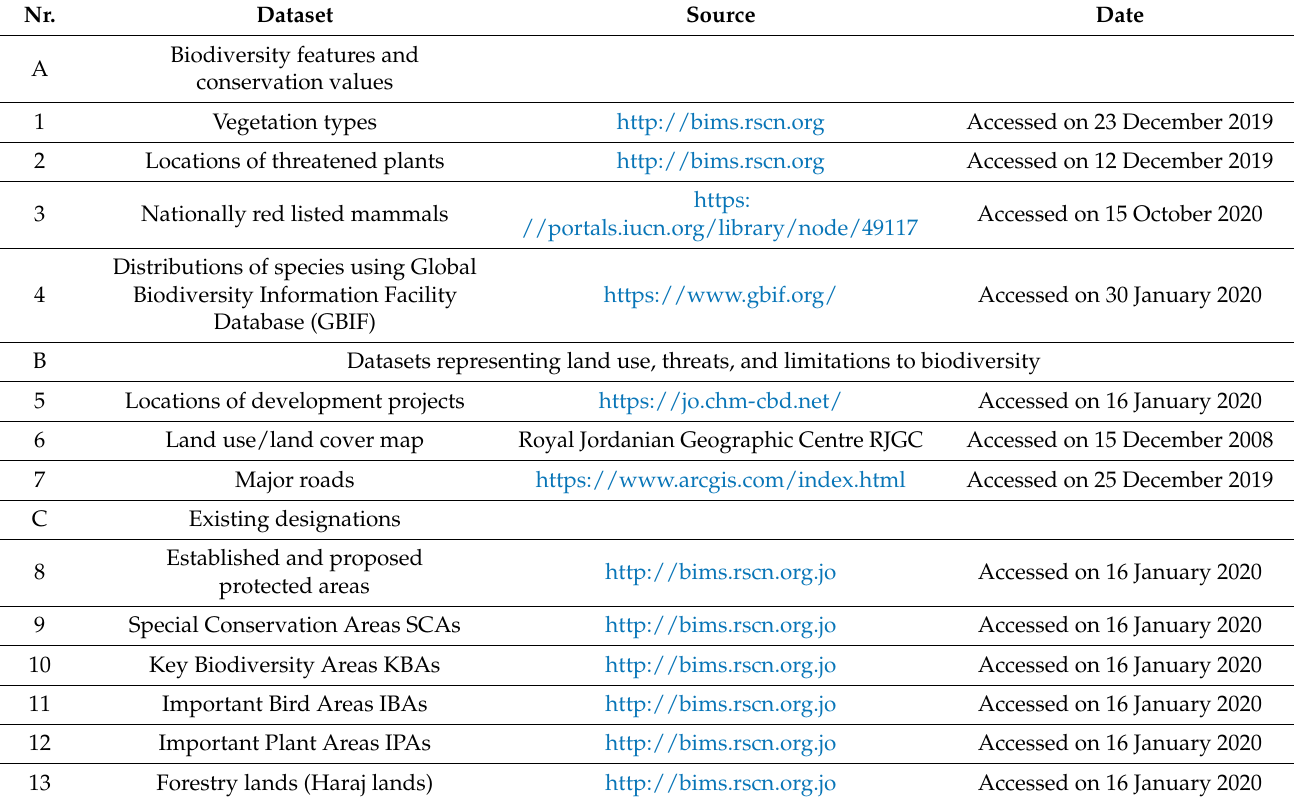
Table 5. Datasets included in preparing Marxan input files in this